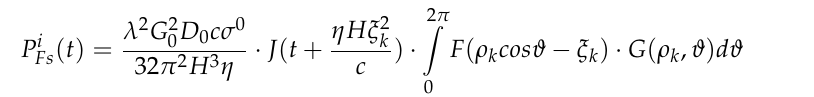
Figure 6. The variation of ( a ) roll angle and ( b ) pitch angle along the flight path. To sum up, a SAR echo model that takes both mis-pointing angle and elliptical beam into account is needed. Reference [29] provides a SAR interferometric (SARIn) altimeter echo model which meets those requirements. The model in [29] is proposed to process the CrySat-2 SARIn power waveform, which could be affected by interferometer angle composed of mis-pointing angle and surface across-track slope. The CrySat-2 altimeter that operates on SARIn mode, is equipped with two antennas to form an interferometric baseline to measure the slope near the glacier margin. However, the airborne altimeter works in non-interferometric, nadir-looking mode, so the SARIn mode is beyond the scope of this paper. Therefore, by setting the baseline length of Equation (1) in [29] to zero, an echo model that applies to nadir SAR altimeter of elliptical beam footprint is